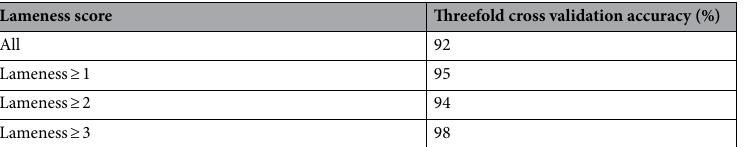
Table 13. Catboost threefold cross validation accuracy for scorer 1 for each of the 3 lameness score groups: separate degrees of lameness, scores 0 as non-lame with scores 1, 2 and 3 as lame, scores 0 and 1 as non-lame with scores of 2 and 3 as lame, scores 0, 1 and 2 as non-lame and a score of 3 as lame.